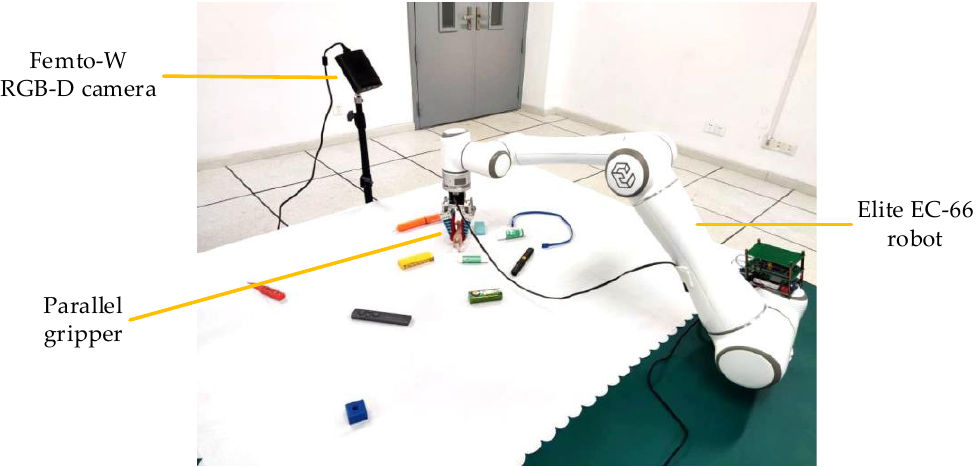
Figure 10. Physical experiment conditions. Experiment instruments include a Femto-W RGB-D camera, an EC-66 collaborative robot, a parallel gripper, and some objects to be